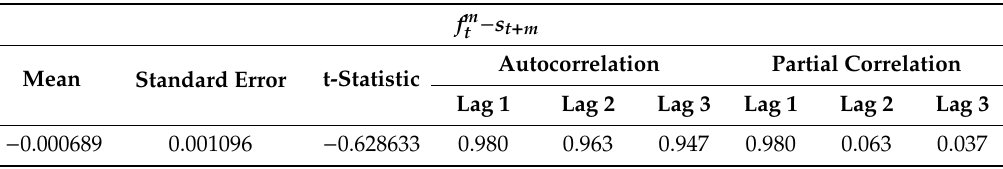
Table 4. Summary statistics for forward rate forecast errors.